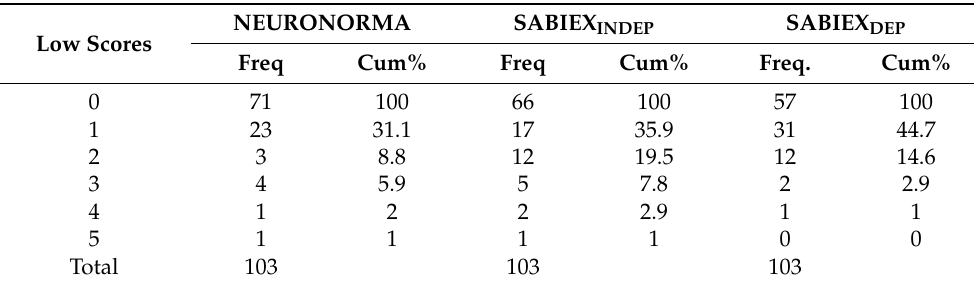
Table 3. Frequency and accumulated percentage of NEURONORMA, SABIEX INDEP and SABIEX DEP low